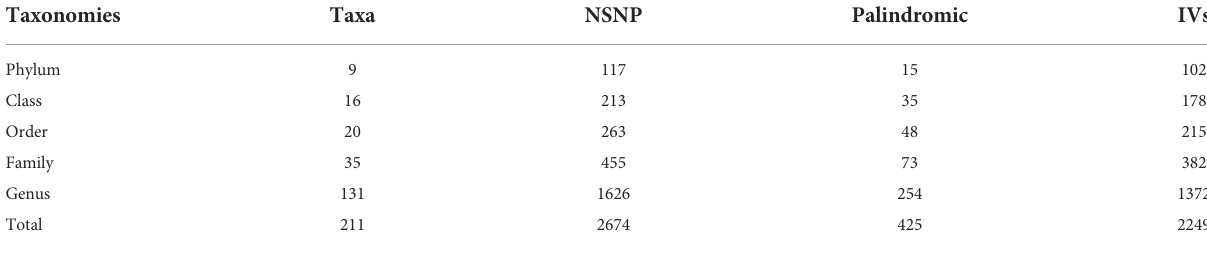
TABLE 1 Selection of IVs after quality control.